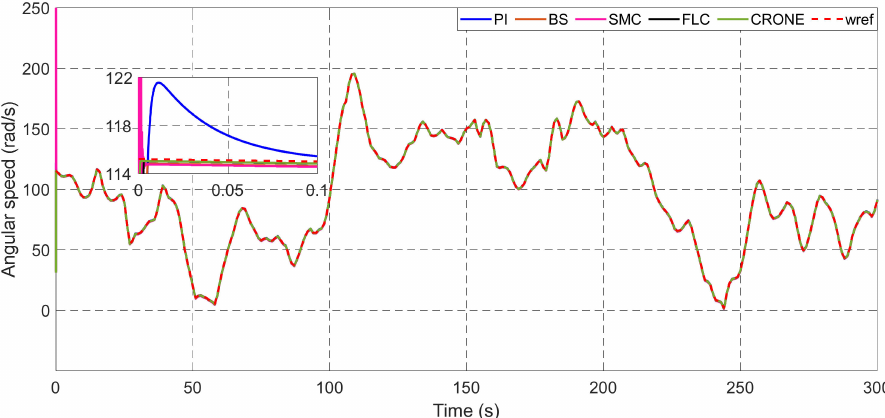
Figure 19. Angular rotor speed for PI, BS, SMC, FLC, and CRONE controllers.